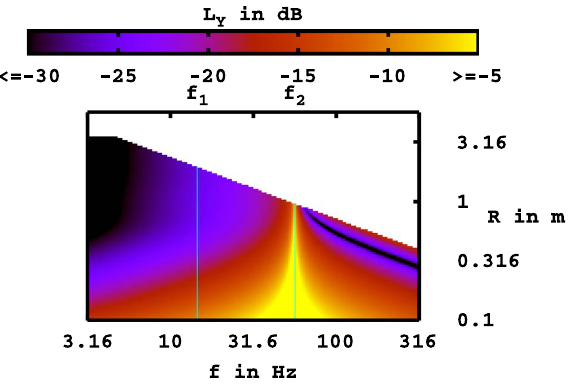
Figure 22. Level of admittance L Y according to (56); cyan marker lines for f 1 and f 2 ; r = 1.0 (cid:5) 10 7 Pa s/m 2 ; large blank upper right corner due to numerical instability.